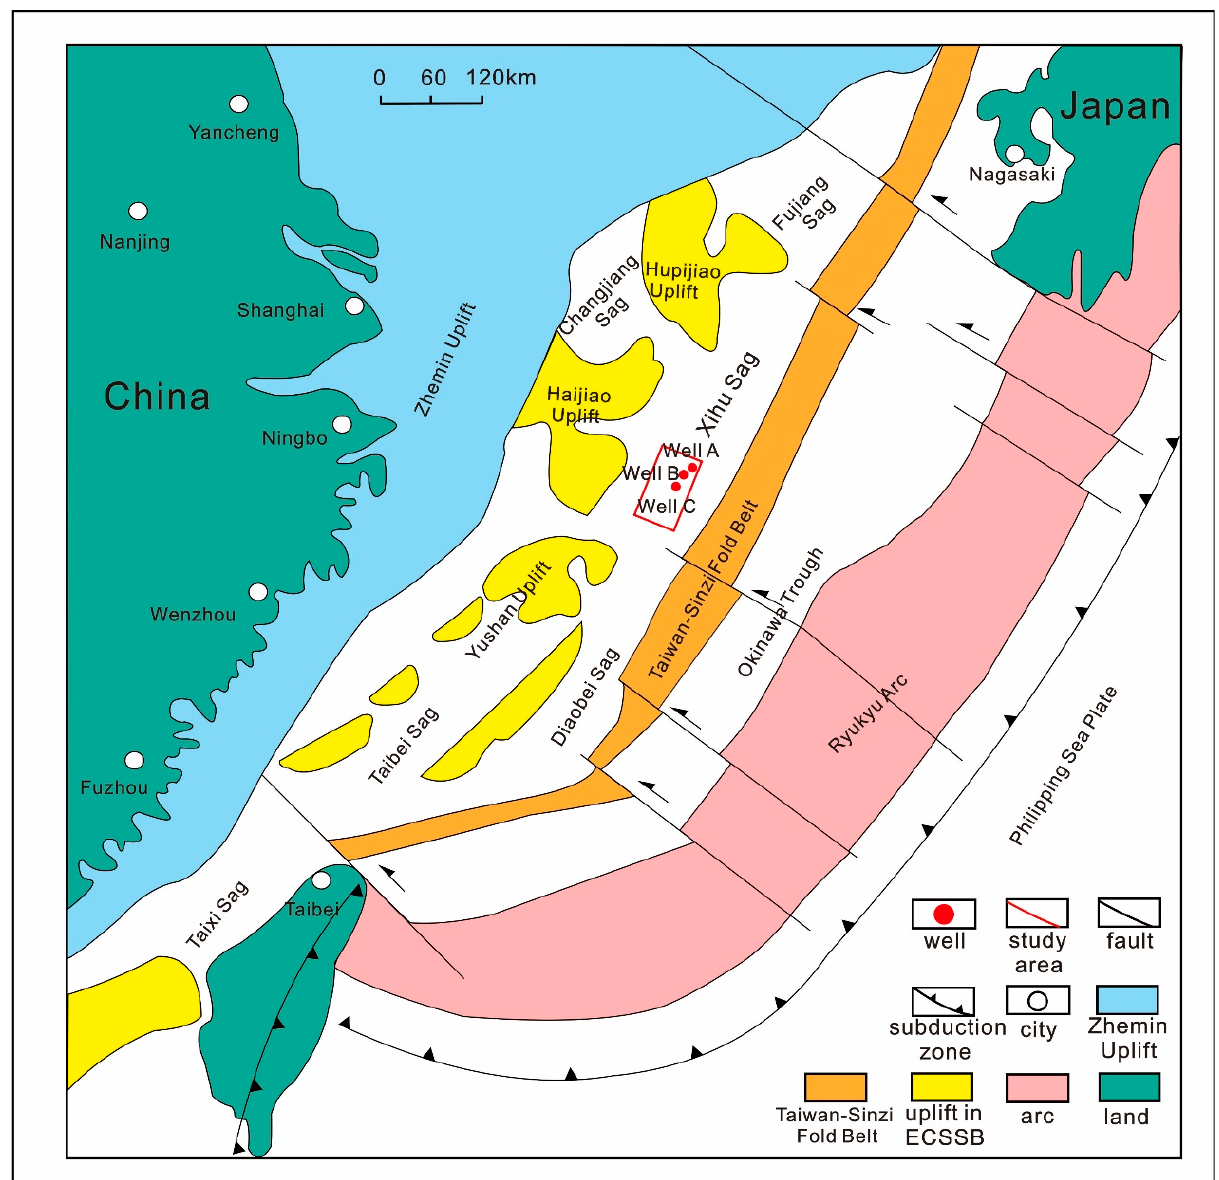
Figure 1. Location map of the study area and tectonic framework of the East China Sea (modified after Hao, 2018).